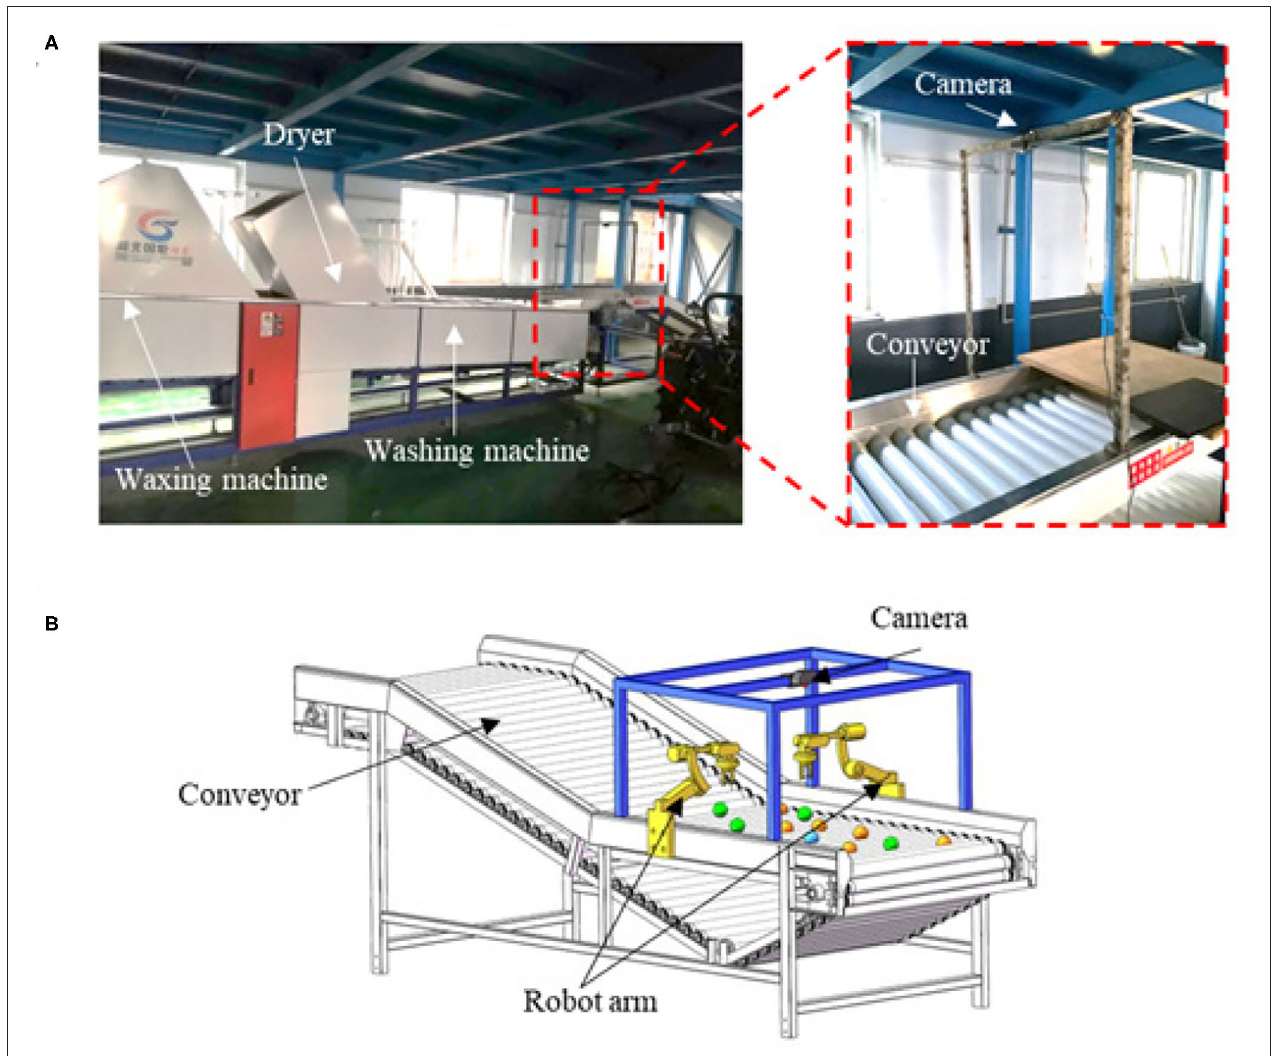
FIGURE 2 | Platform setup and computer vision system. (A) The citrus processing line assembled in the lab, with a webcam mounted above the conveyor. (B) The diagram showing an automated citrus sorting system using a camera and robot arms, and the robot arms will be implemented in future work.